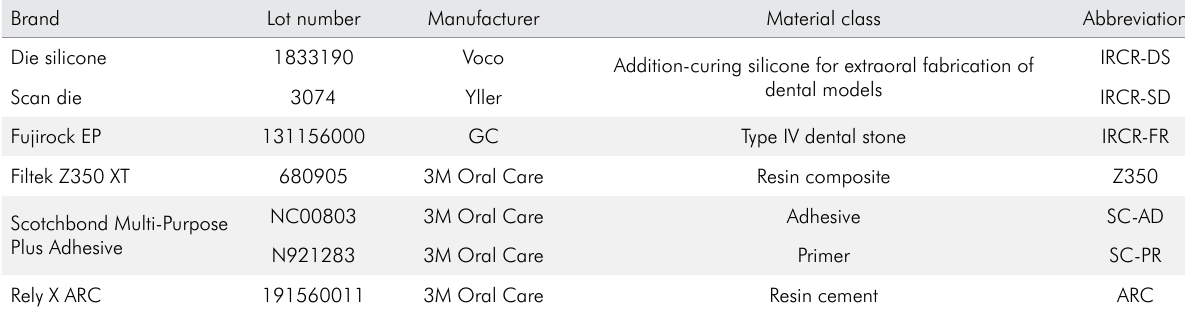
Table 2. Summary of materials